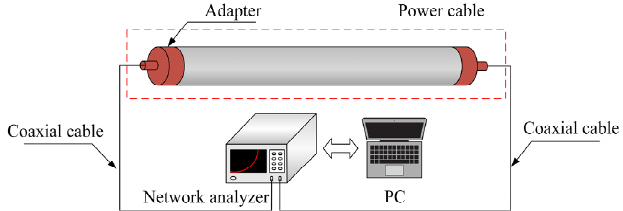
Figure 12. Schematic diagram of the phase constant measuring system.